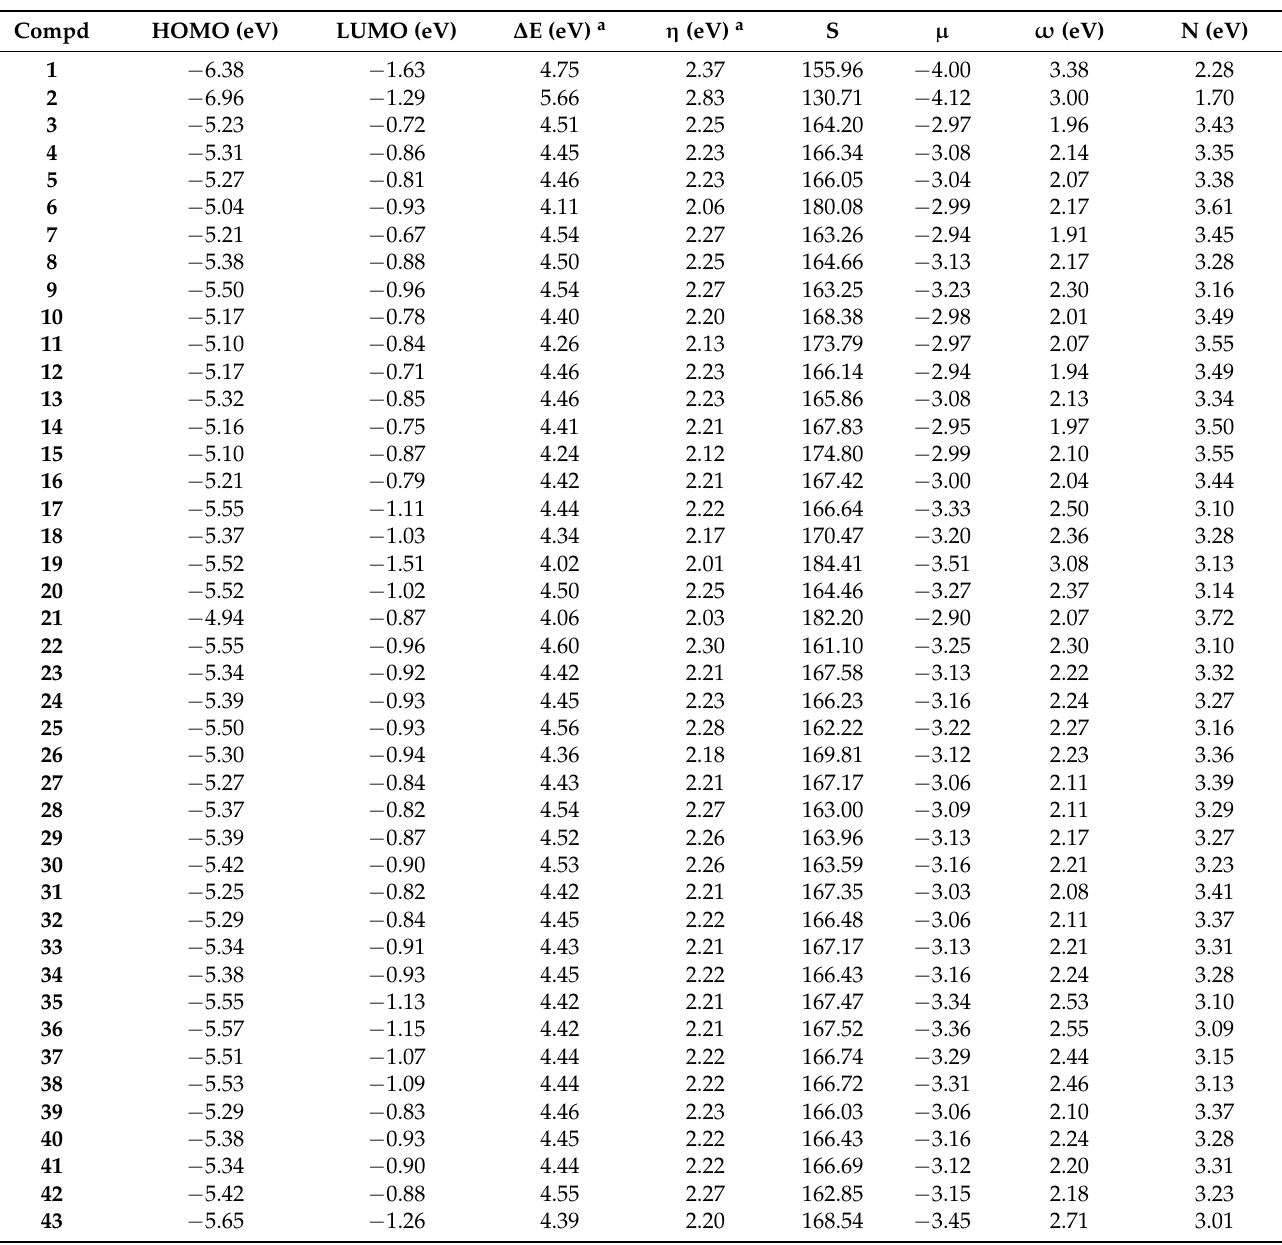
Table 3. The HOMO and LUMO energy, energy gap ( ∆ E), and reactivity indices ( η , S, µ , ω , and N) of the 43 compounds under